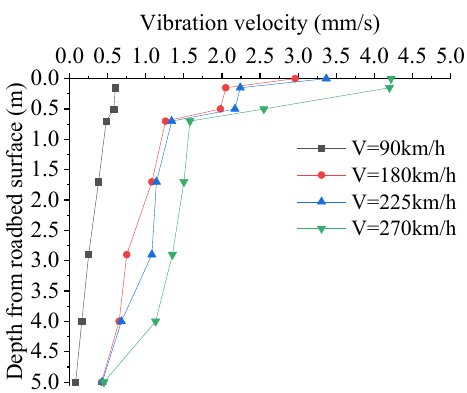
Figure 14. Distribution of the vibration velocity amplitude along the vertical direction from the roadbed.